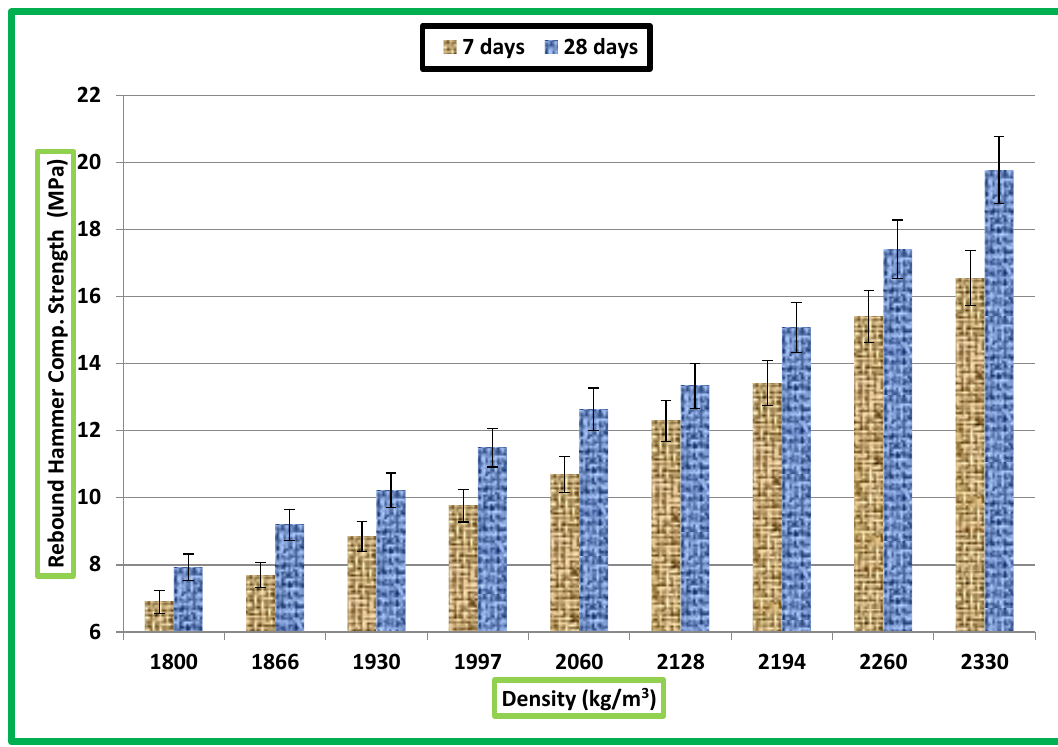
Figure 16. Rebound hammer-based compressive strength (MPa) at 7 and 28 days.